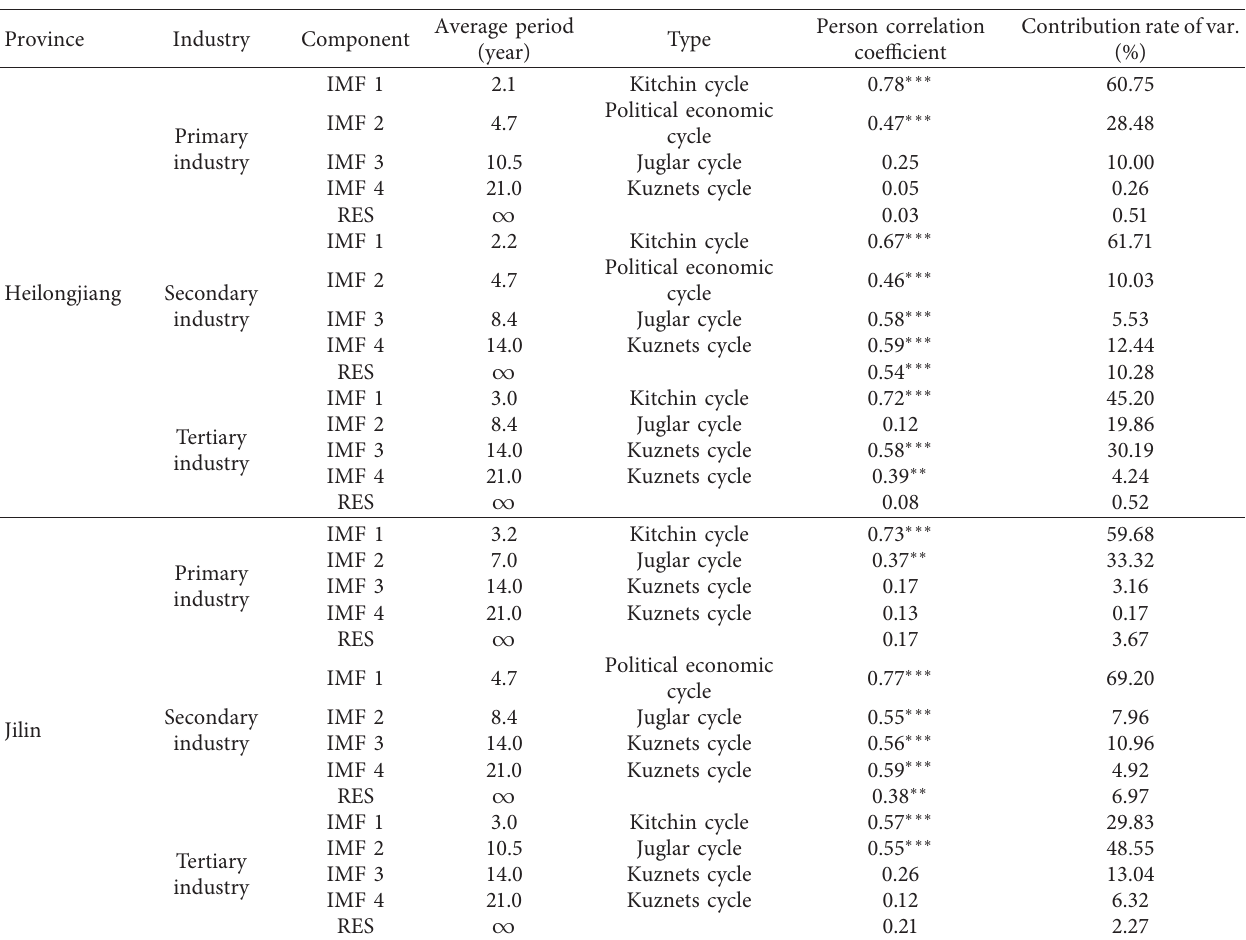
Table 2: Statistical features of components and trend terms of industrial